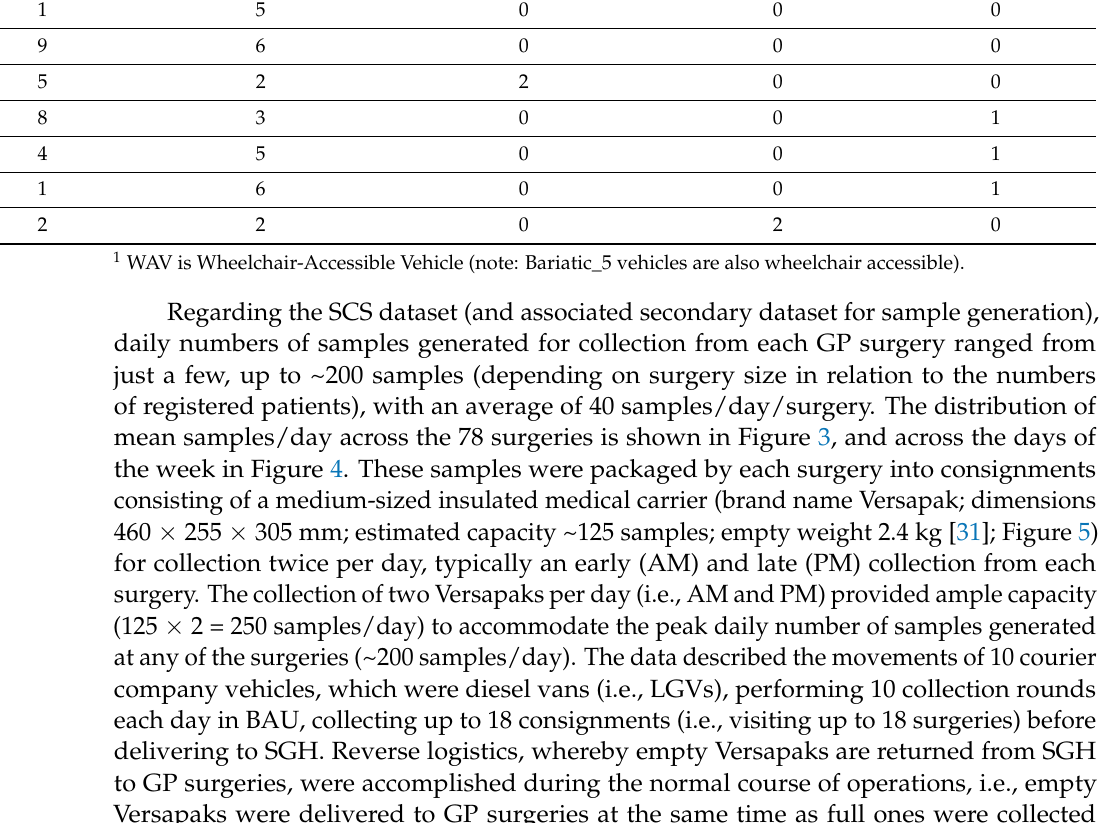
Figure 2. Map showing locations of Eastleigh PTS depot, GP surgeries and Southampton General Hospital (SGH). Red circle shows the location of Eastleigh PTS depot, blue circles show locations of GP surgeries and green cross shows the location of SGH.